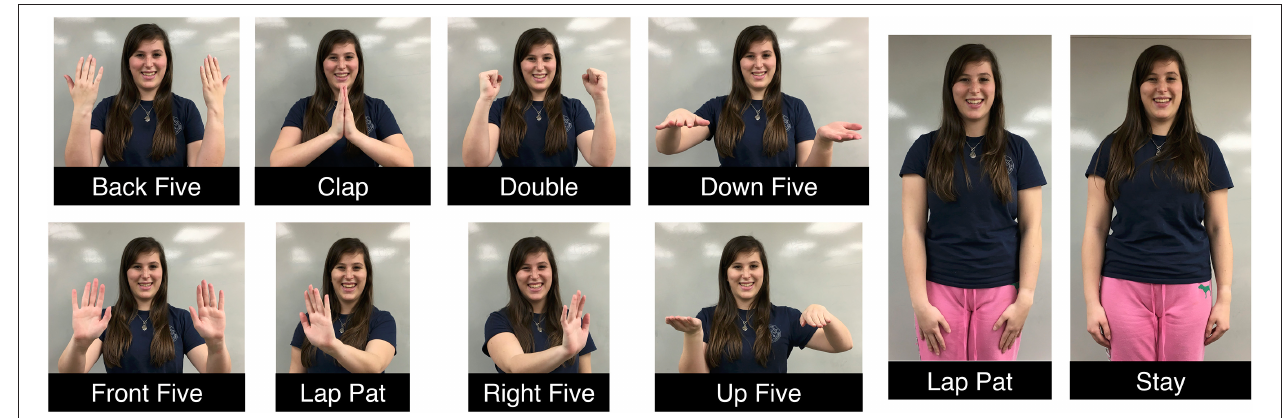
FIGURE 2 | Labeled images of a person performing the studied set of hand-clapping motions. The individual shown in these images provided written consent for these images to be published.